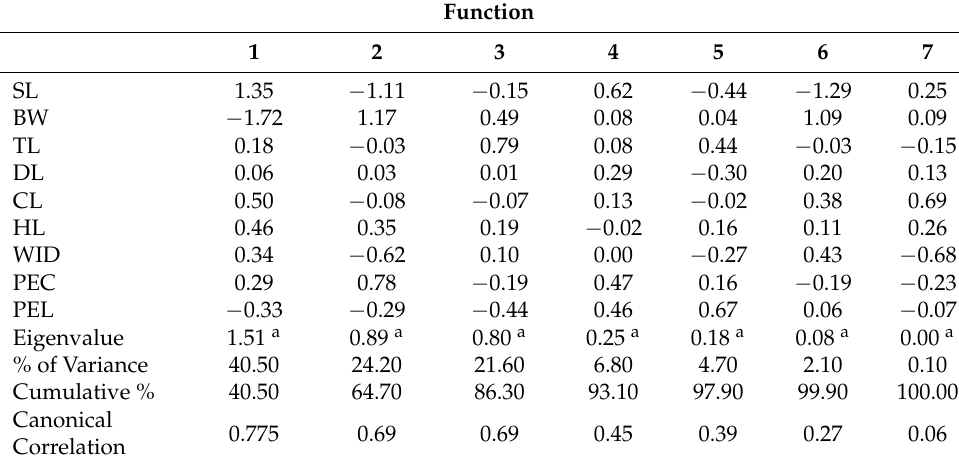
Table 3. Standardized Canonical Discriminant Function Coefficients for Morphological characters of O. niloticus